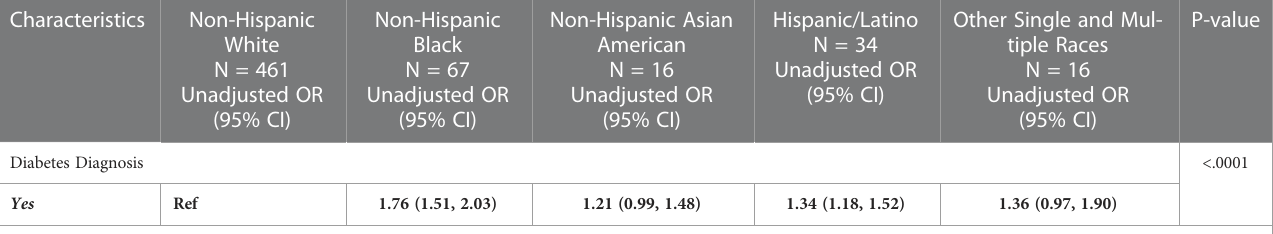
TABLE 3 Diabetes Prevalence by Racial and Ethnic Category, 2021 NHIS a,b .